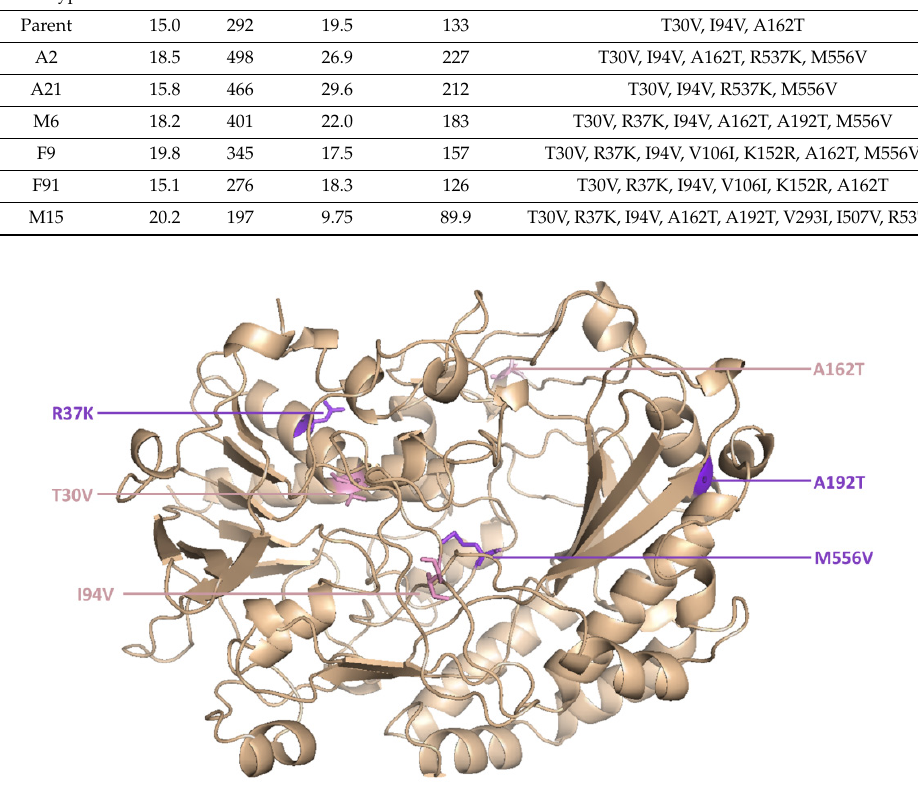
Figure 5. The M6 mutant of glucose oxidase features amino acid substitutions at six positions .